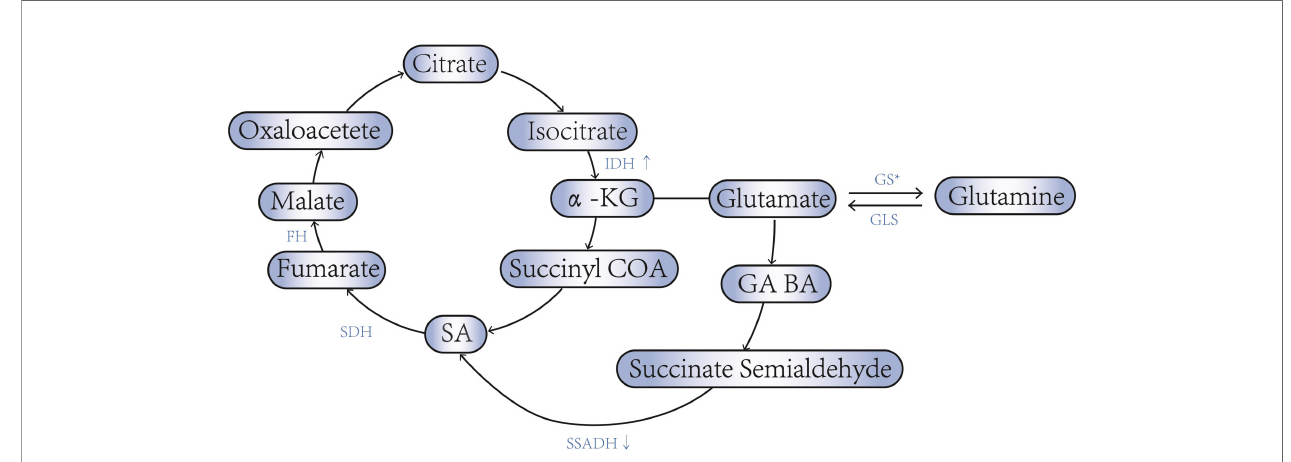
FIGURE 1 | SA - associated enzyme abnormalities in ovarian cancer. * Low invasive ovarian cancer cells express high levels of GS, while high aggressive ovarian cancer cells express low levels of